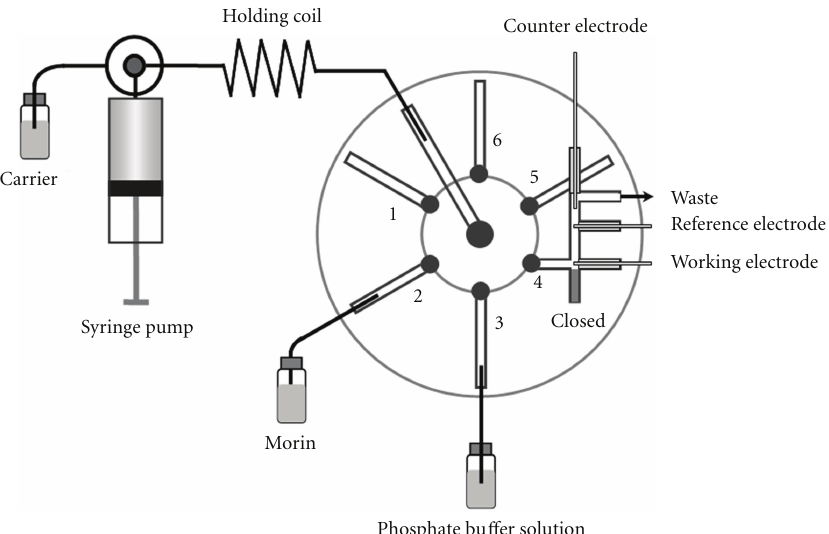
Figure 2: Schematic diagram of the SI-LOV manifold in conjunction with amperometry for the determination of